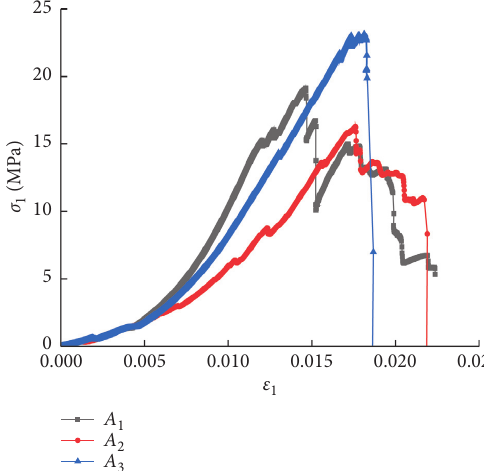
(1) Roof presplitting blasting (Figure 10): this cuts off the connection of the overburden roof, loosens the top coal, and reduces the stress concentration in the coal body. (2) Pressure relief of large-diameter holes in the side (Figure 11): this plays the role of energy absorption, hole closure, and pressure relief and reduces the internal energy accumulation in the coal body.